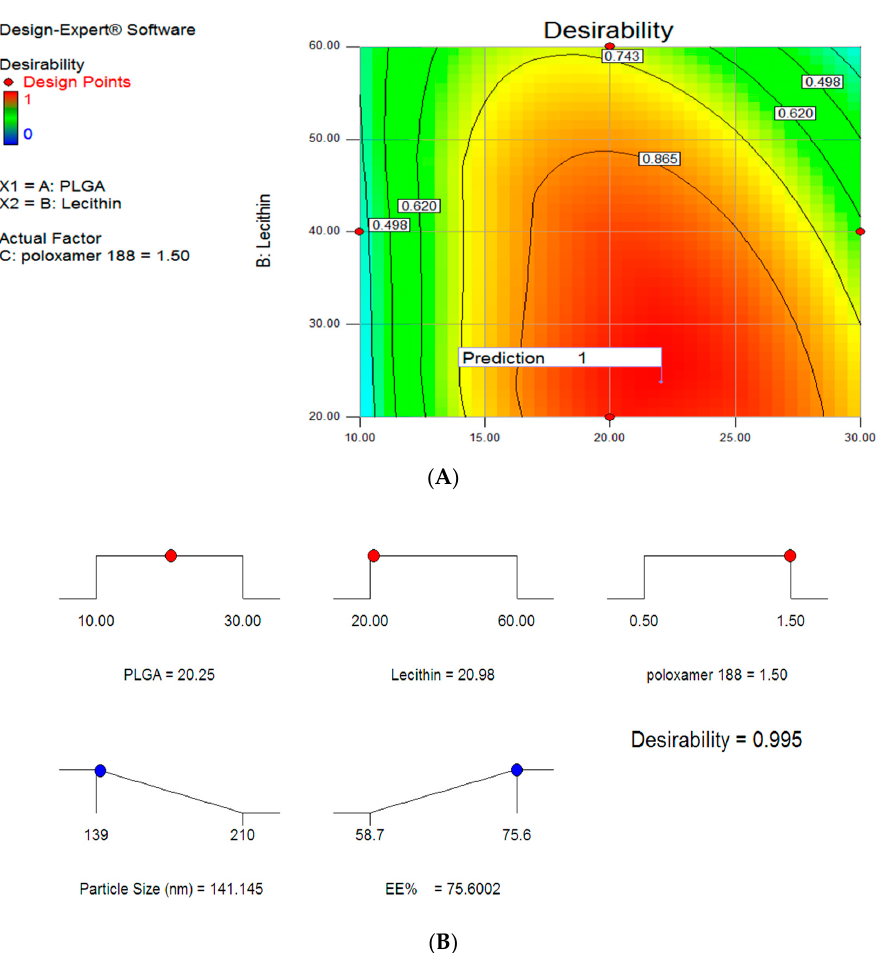
Figure 3. Desirability ramp for optimized conditions for PLNs process conditions. ( A ) represents the relationship between independent variables and desirability values, ( B ) obtained values from software to represents optimum conditions for PLNs, red bullets are of independent variables and blue ones are of dependent variables that give better desirability.